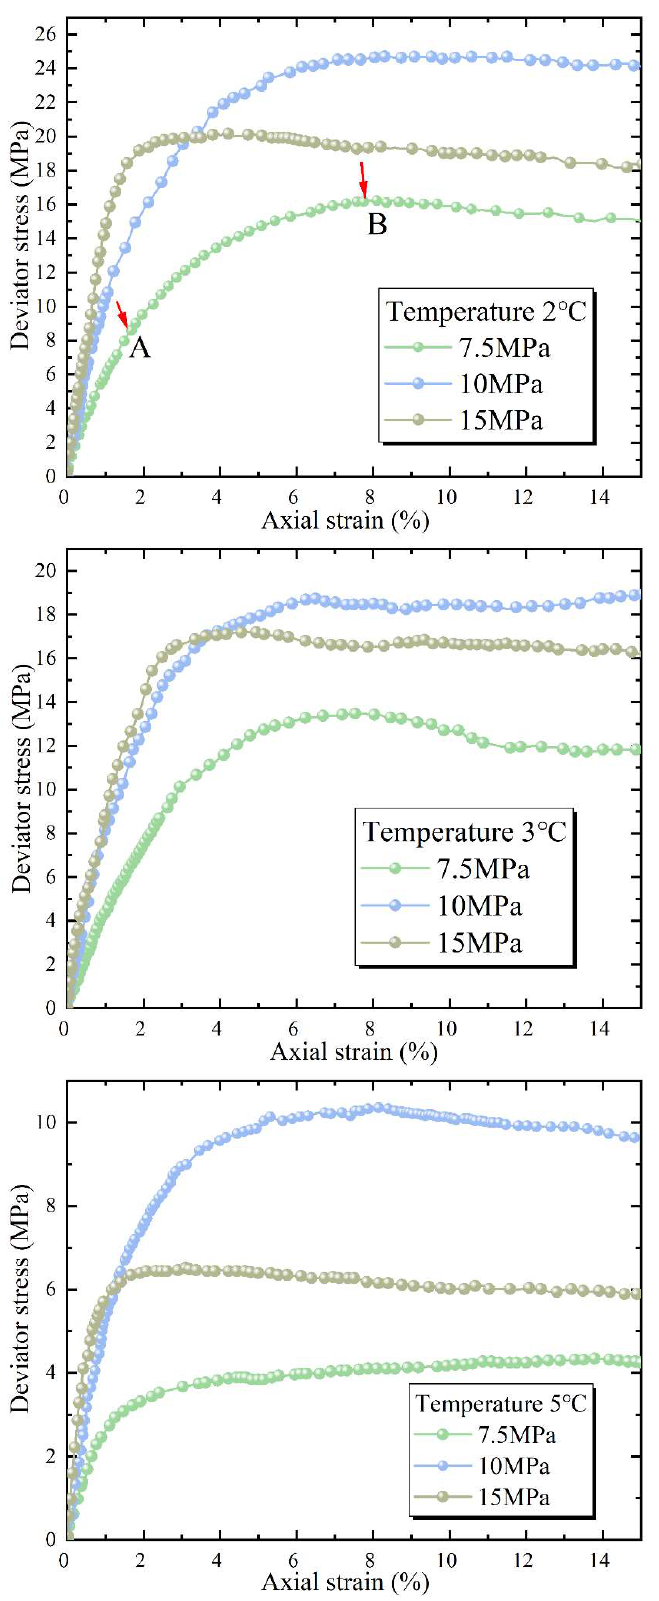
Figure 7. Stress–strain curves of MHBS at various temperatures and confining pressures.